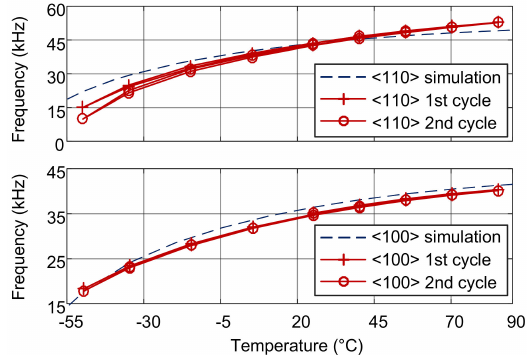
Figure 7. Natural frequency of the DETFs without stress isolation.